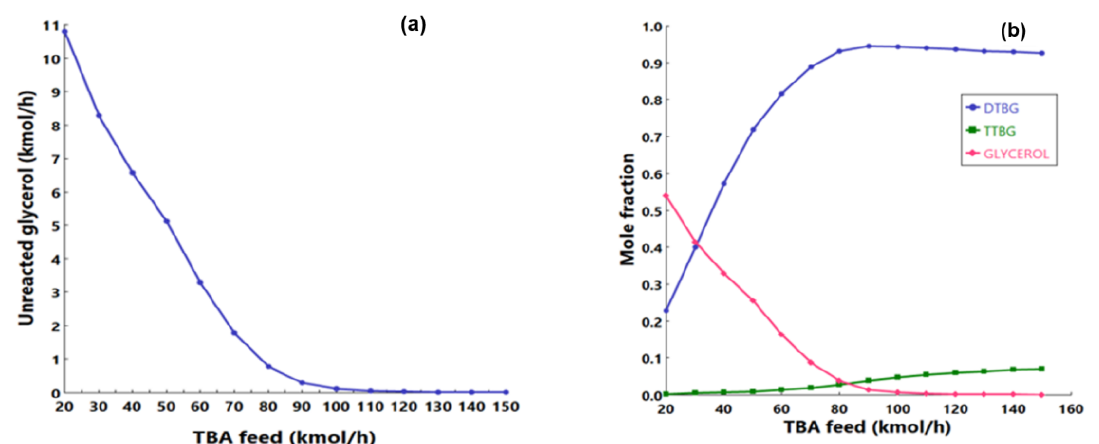
Figure 10. For Reflux ratio = 1.1, reactive stages = 6, ( a) Unreacted glycerol in the bottom stream as a function of TBA feed flow rate, ( b ) Unreacted glycerol, DTBG, and TTBG mole fractions in the bottom stream as a function of TBA feed flow rate.